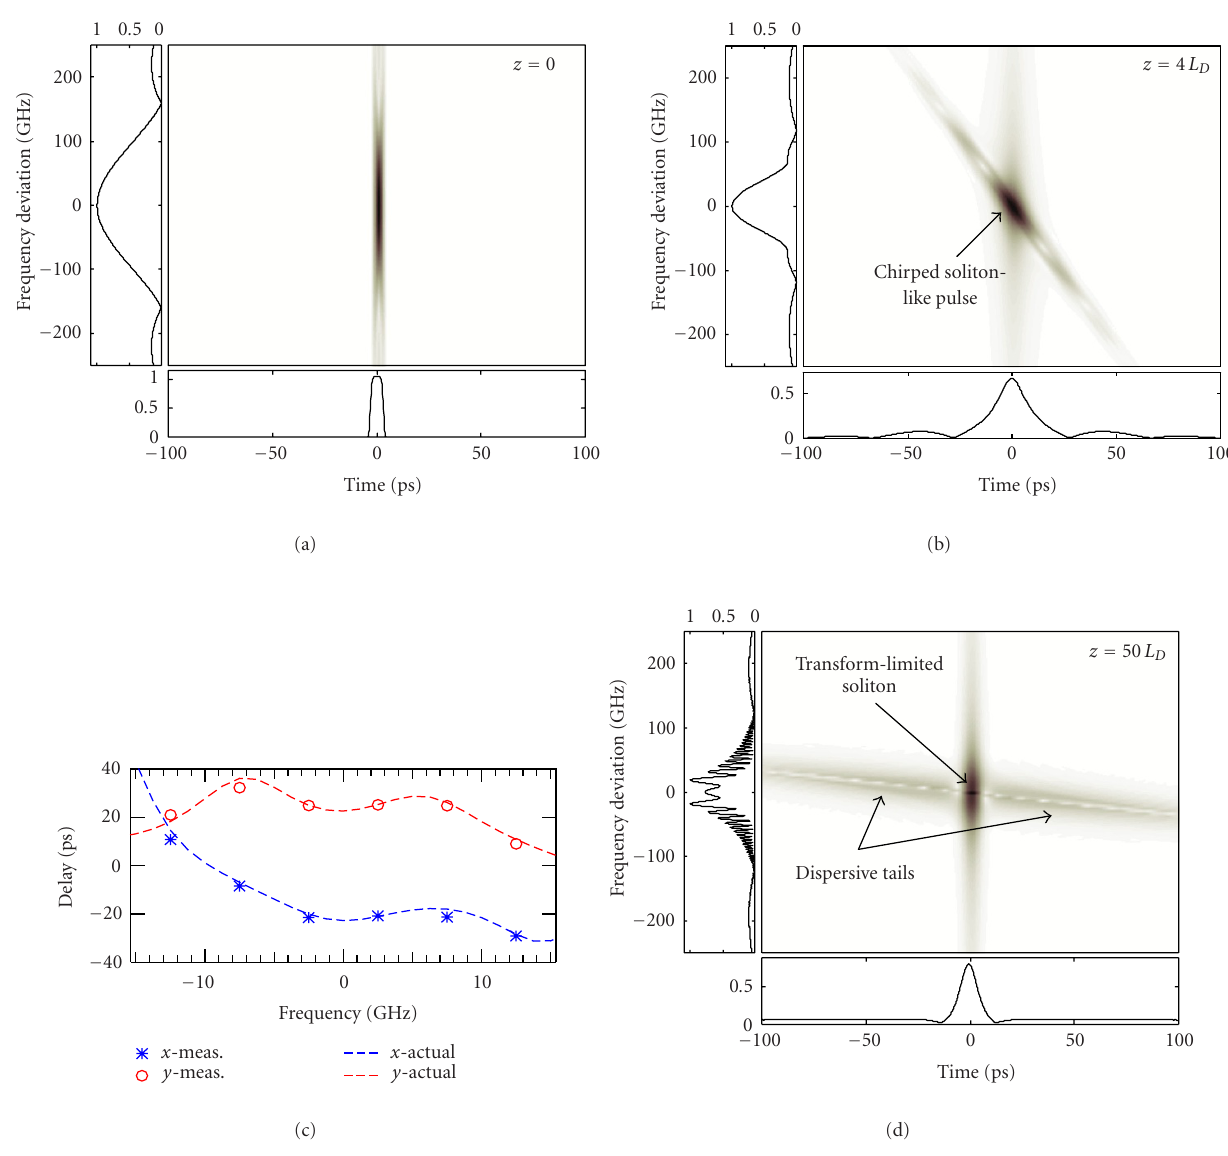
Figure 5: Wigner analysis of fundamental soliton formation in an optical fiber (anomalous dispersion regime).